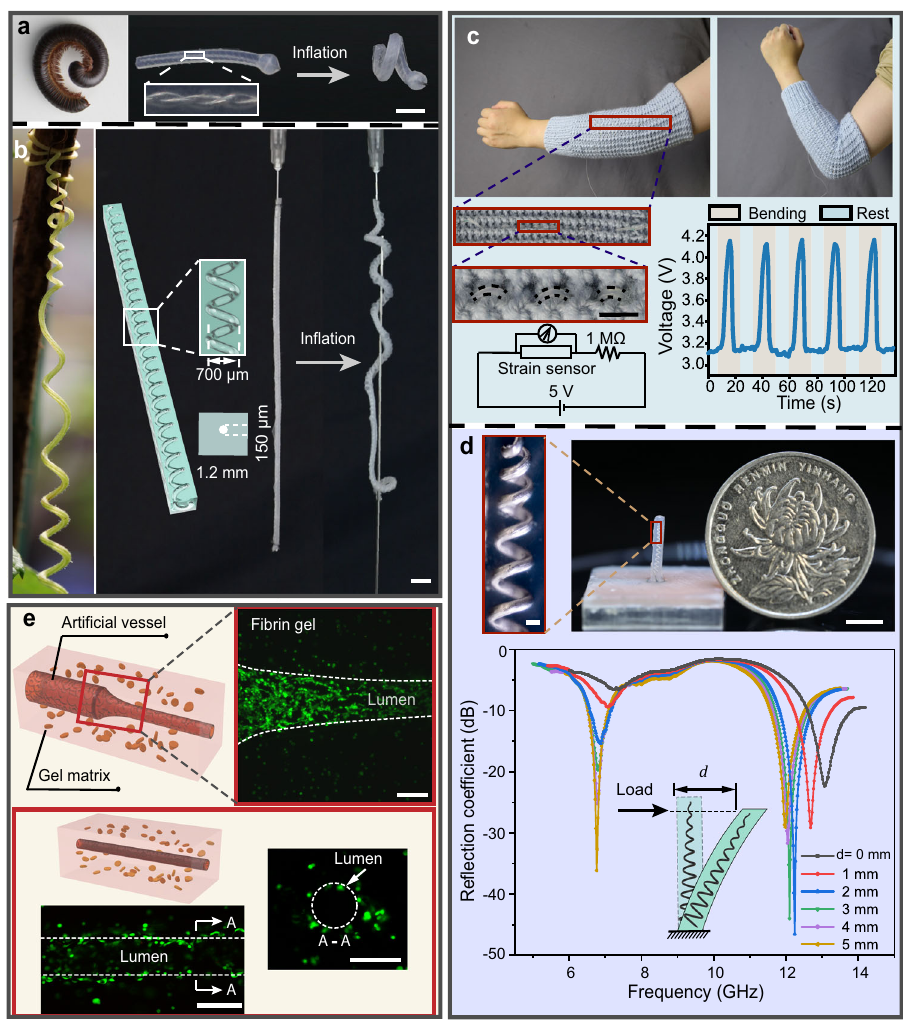
Fig. 5 | Demonstrative applications of soft demoulding. a The pneumatic soft robotinatwistingstatemimicsthemillipedeinadefencestate(leftinset)usingthe plectoneme microchannel. Scale bars a – d , 5mm. b The long, soft tendril robot (length: 10cm) containing a helical microchannel (diameter: 150 µ m) (aspect ratio>1600) climbs on a rod after being in fl ated, like the real tendril (left inset). c The soft, thin, long strain sensor (channel diameter: 150 µ m, length: 15cm) cap- able of acquiring the elbow motion. d The soft antenna containing a 3D helical microchannel (diameter:180 μ m) exhibiting different re fl ectioncoef fi cients under